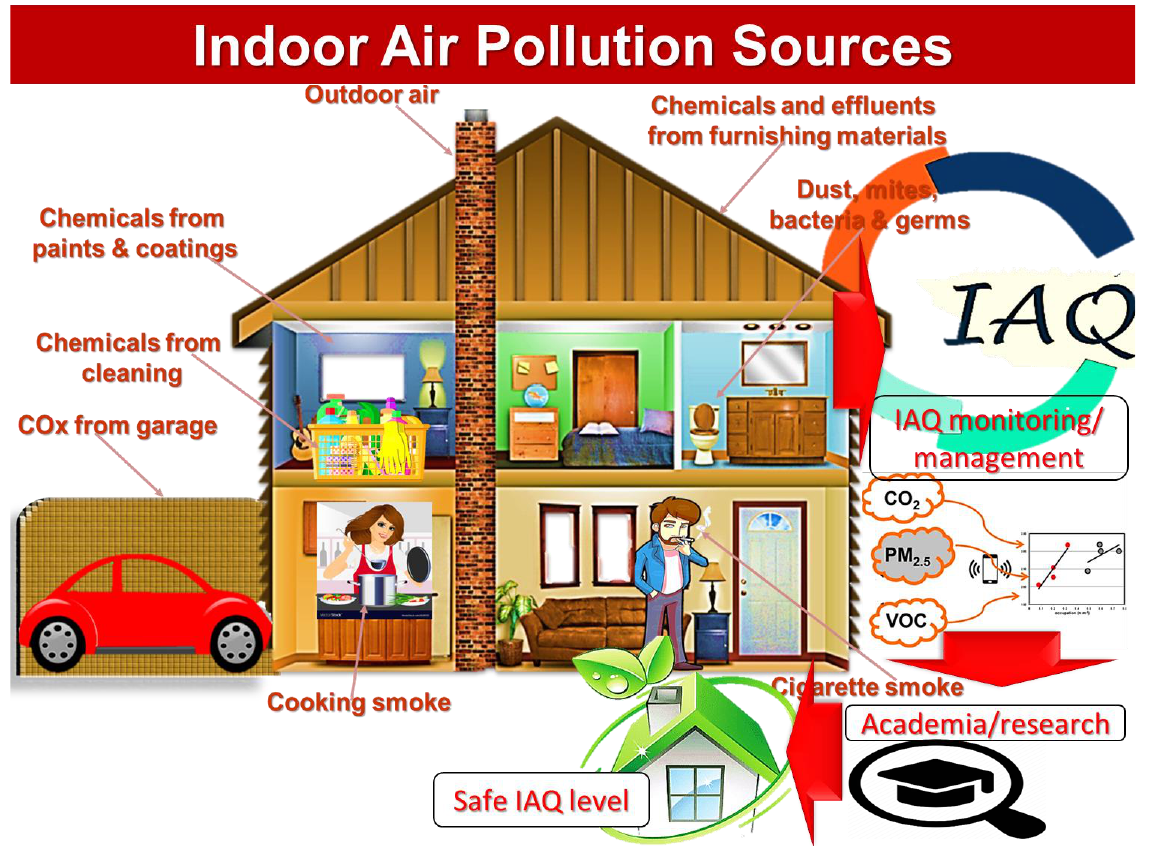
Figure 1. Common pollutants and sources in indoor air.